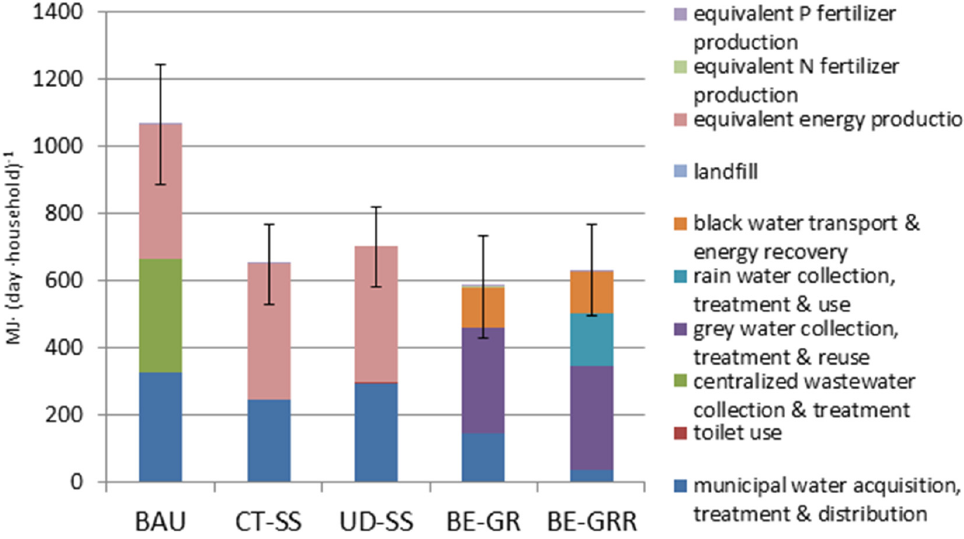
Figure 2. Life cycle energy consumption of water systems, MJ·(day·household) − 1 . The range of variability bar presents the values at the assumed fifth and 95th percentiles.